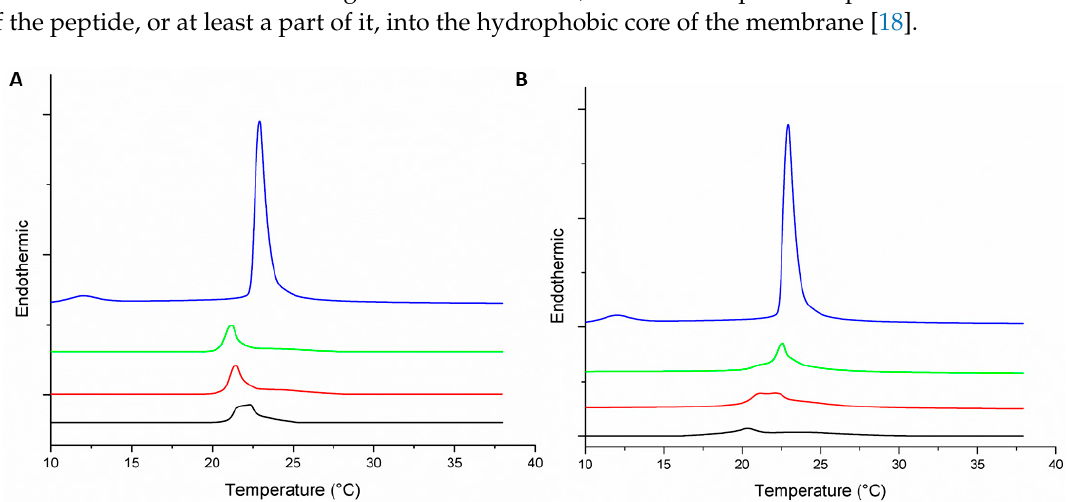
Figure 2. Differential scanning calorimetry (DSC) thermograms representing endothermic peaks of the phase transition of multilamellar vesicles (MLVs) formed by 1,2dimyristoyl-sn-glycero-3- phosphocholine (DMPC) under the effect of peptide +2 ( A ) and peptide +5 ( B ) at different peptide– lipid molar ratios: 0:1 (